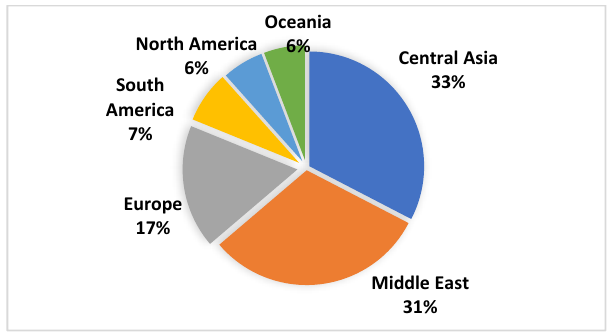
Figure 2 . Regional distribution of respondents . Figure 2. Regional distribution of